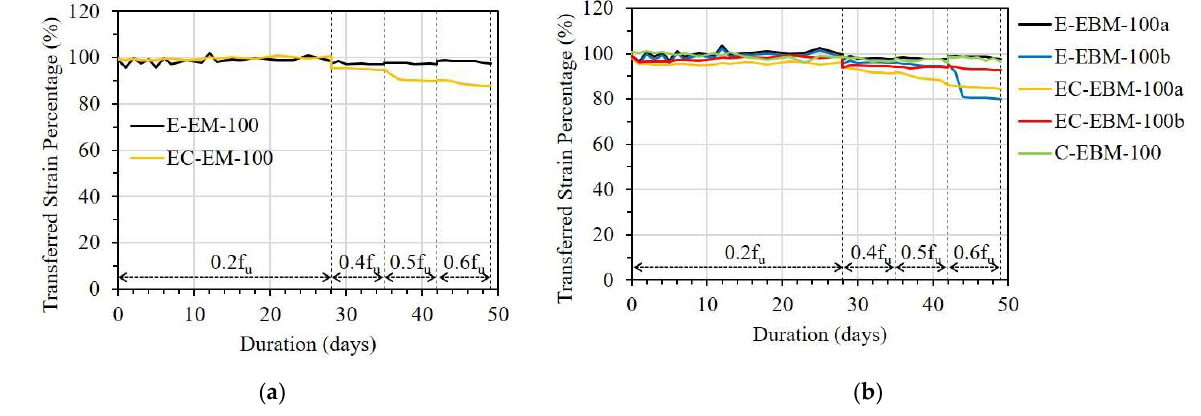
Figure 20. Short-term creep effect on shear transfer with different types of adhesives: ( a ) EM with bond length of 100 mm and ( b ) EBM with bond length of 100 mm.